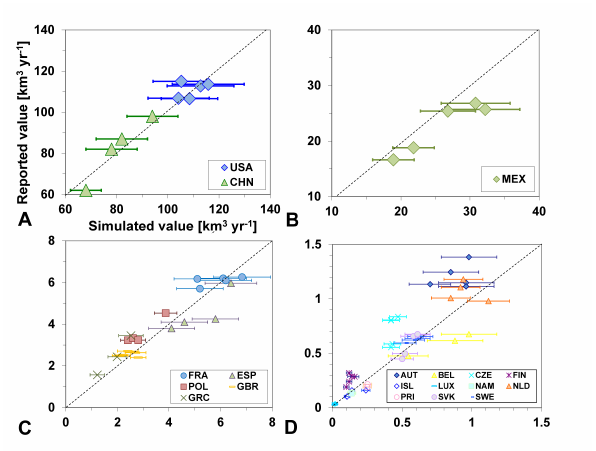
Fig. 4. Comparison of simulated and reported trends of groundwa- ter withdrawal per country over the period 1980–2005 ( N = 19). The comparison is given in 5yr interval according to the reported values including missing values for some years. Countries are iden- tified with their ISO country codes: (a) the USA (USA) and China (CHN); (b) Mexico (MEX); (c) France (FRA), the UK (GBR), Poland (POL), Greece (GRC), and Spain (ESP); (d) Austria (AUT), Belgium (BEL), the Czech Republic (CZE), Finland (FIN), Is- rael (ISL), Luxemburg (LUX), Namibia (NAM), the Netherlands (NLD), Puerto Rico (PRI), Slovakia (SVK), and Sweden (SWE). Reported groundwater withdrawal was obtained from the FAO AQUASTAT database. Simulated value indicates the mean of the simulation with the ERA-Interim and MERRA climate. Error bars show standard deviation ( σ) among the simulation with the ERA- Interim and MERRA climate. The dashed line represents the 1 : 1